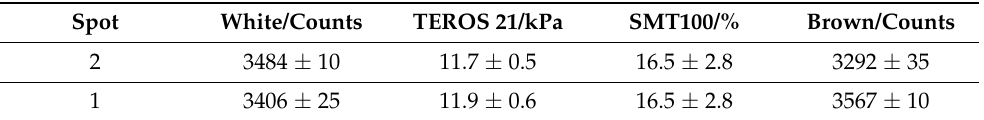
Table 3. Data for the irrigation events at spots 2 and 1.